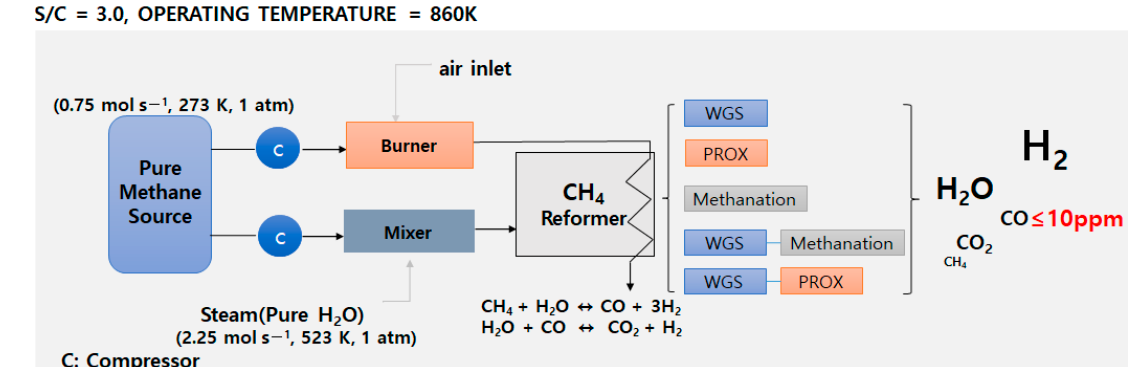
Figure 2. Schematic of methane reforming